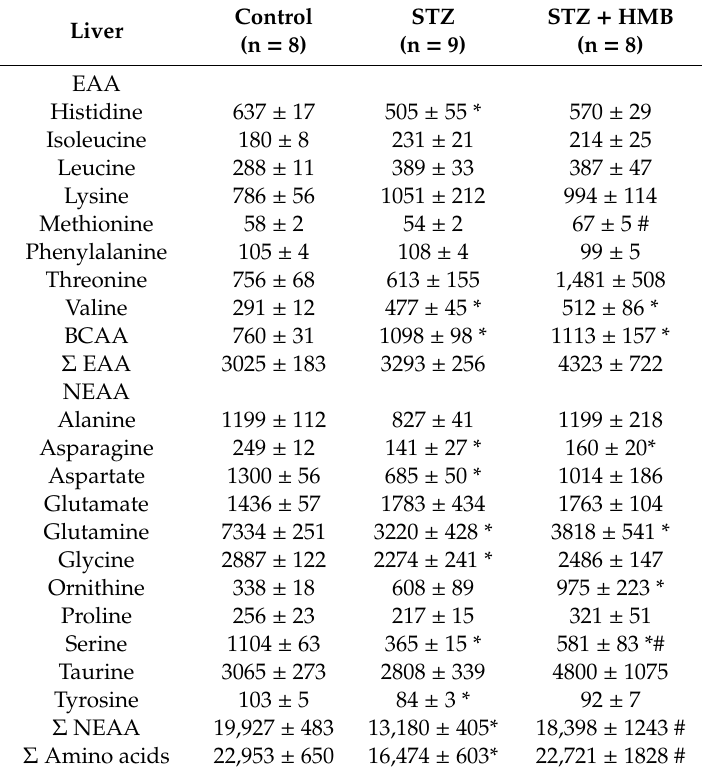
Table 4. Amino acid concentrations in the liver.